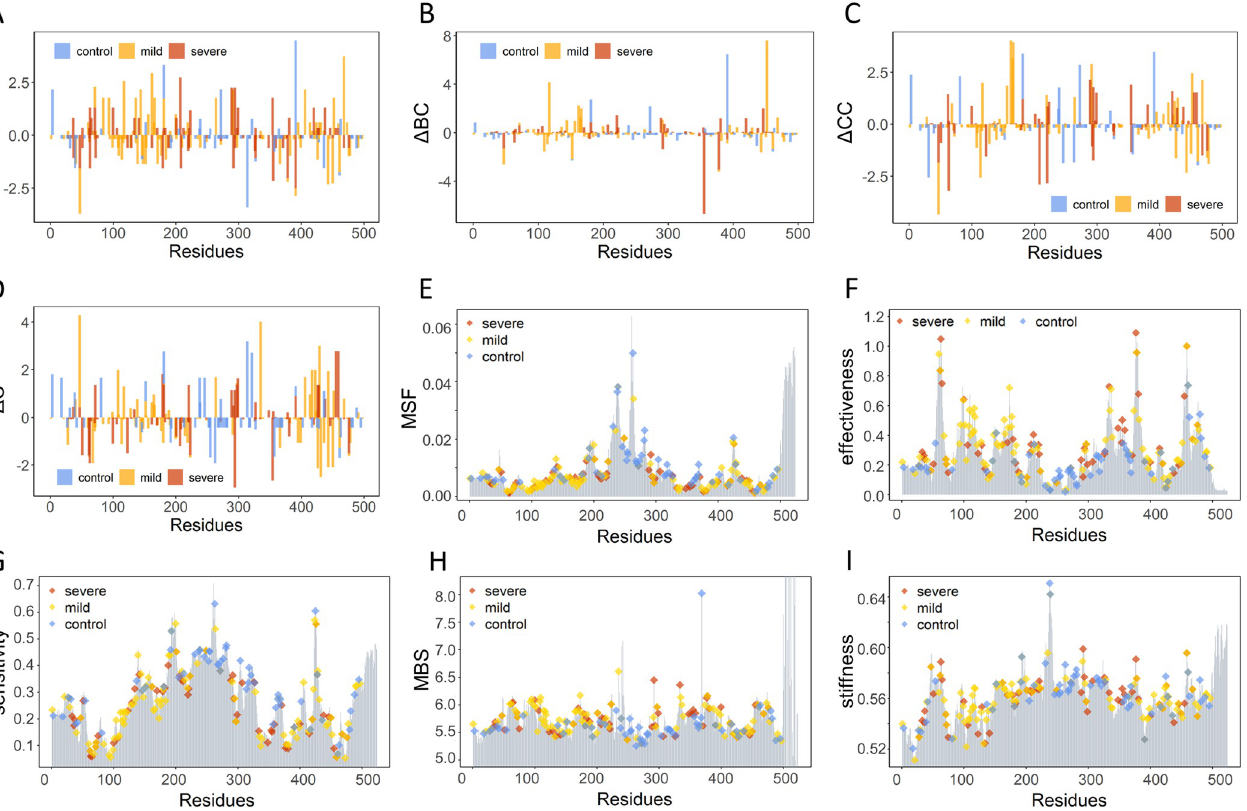
Fig 5. Network topological and dynamic analysis of mutations in ALPL . (A) Δ DC, (B) Δ BC, (C) Δ CC, (D) Δ C, (E) MSF, (F) effectiveness, (G) sensitivity, (H) MBS, and (I) stiffness profiles for the three types of mutations. Control, mild and severe mutations are represented as blue, orange, and red bars, respectively.